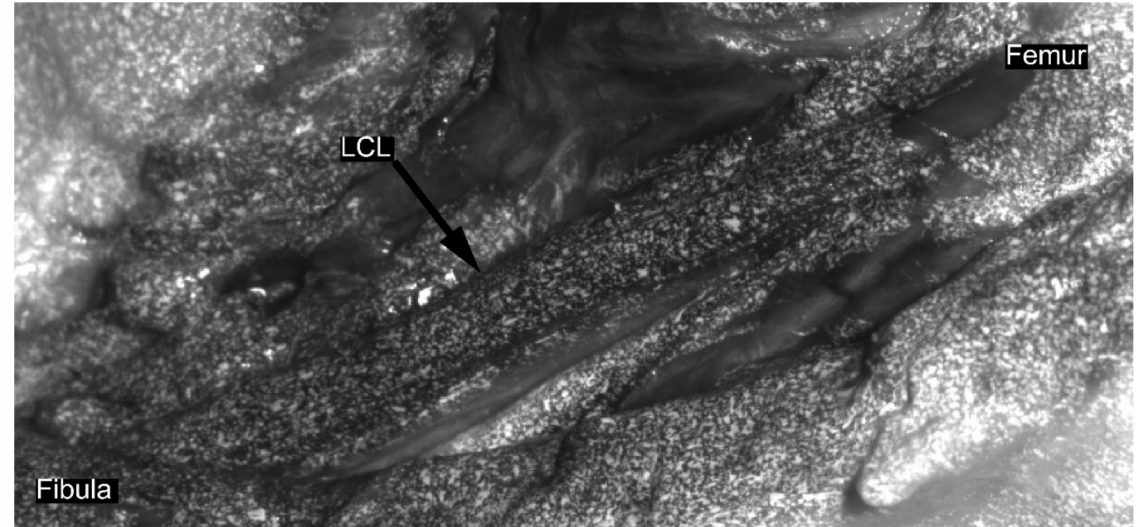
Figure 2. Representative speckle pattern for lateral collateral ligament prior strain computation using digital image correlation. First, diluted methylene blue was applied on the ligament to create a dark background; then, a speckle tracking was applied with white paint using an airbrush gun, following the previously published procedure